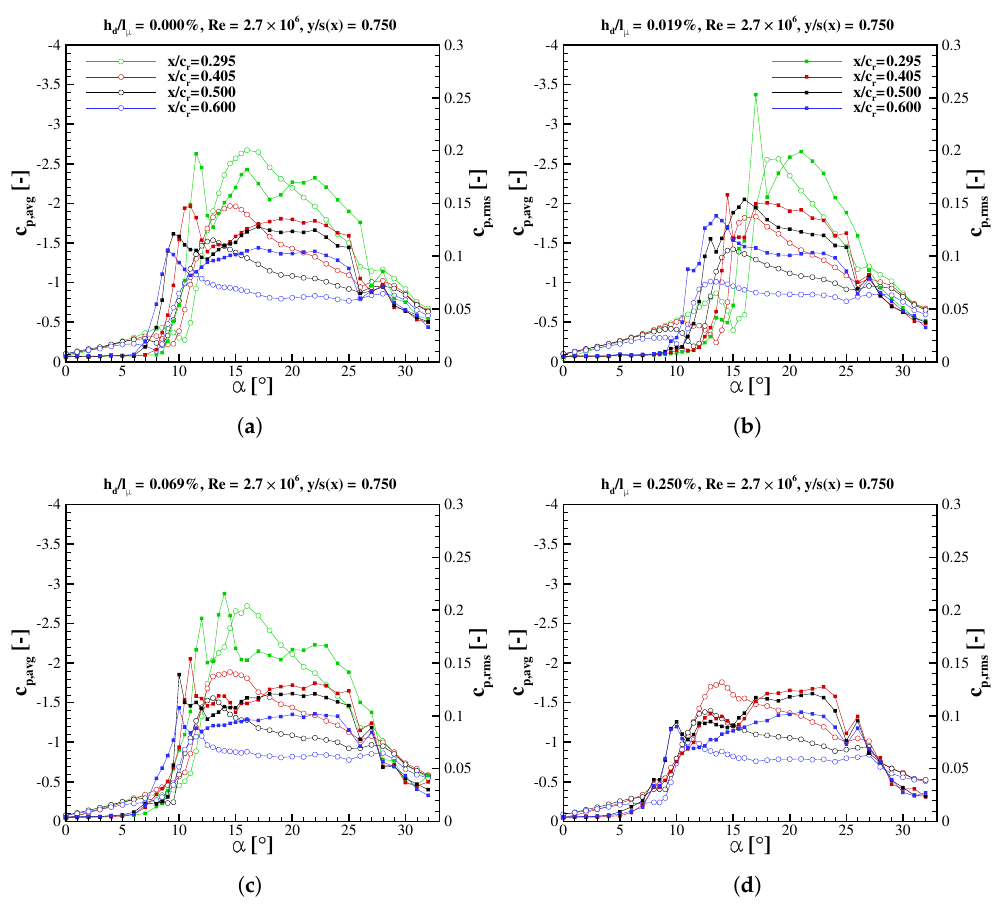
Figure 14. Time averaged c p , avg and rms values c p , rms of the pressure coefficient (circles and full squares, respectively) measured at 0.75 local span as function of angle of attack α and local chordwise position x / c r . Leading-edge roughness heights: ( a ) h d / l µ = 0.000%; ( b ) h d / l µ = 0.019%; ( c ) h d / l µ = 0.069%; ( d ) h d / l µ =